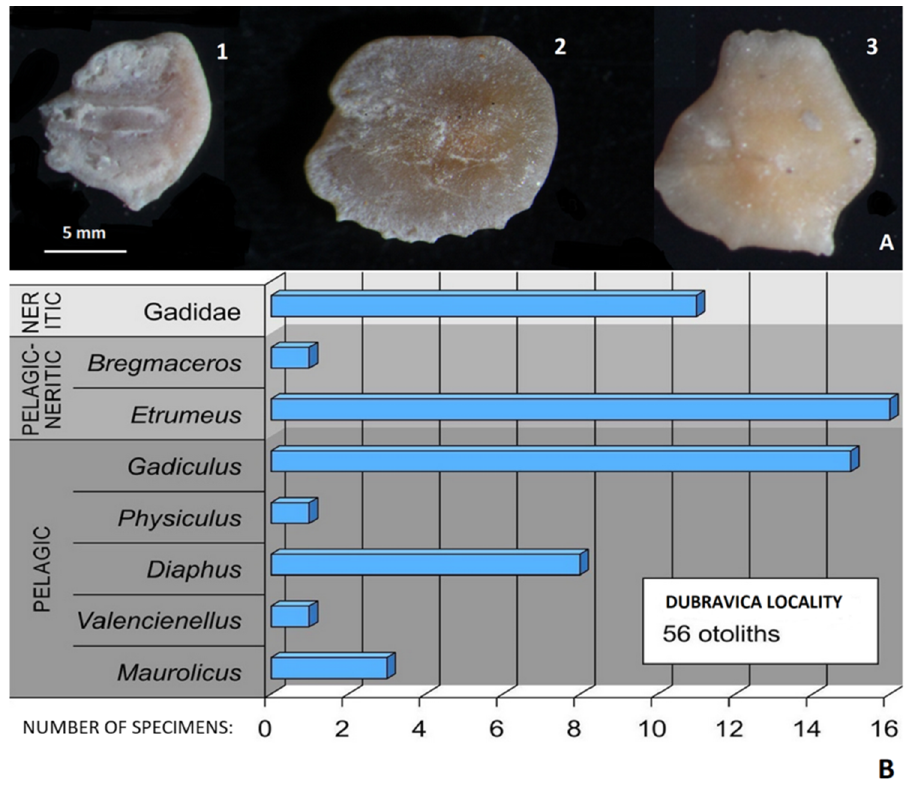
Figure 16. ( A ) Otholiths from the Middle Miocene deposits from the Dubravica locality, SW Medvednica Mt. (area 1 in Figure 3, for the localities see Figures 10 and 12): 1. Bregmaceros Thompson, 1840; 2. Diaphus C. H. Eigenmann and R. S. Eigenmann, 1890; 3. Maurolicus Cocco, 1838; ( B ) amount of the neritic, pelagic-neritic and pelagic taxa in otolith assemblage ([116], modified). Based on the stratigraphic span of the planktonic and benthic biota, Middle Miocene biostratigraphy can be correlated with other relevant data (Figures 4 and 17).